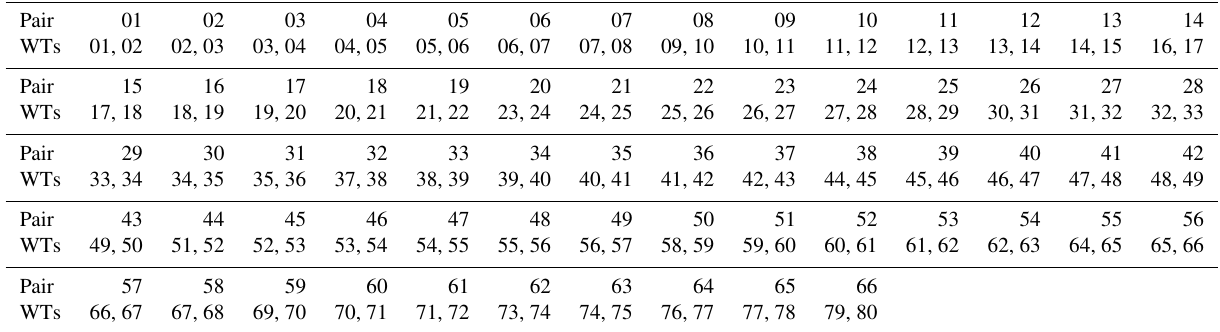
Table A1. Definition of streamwise wind turbine (WT) pairs for wind direction 270 ◦